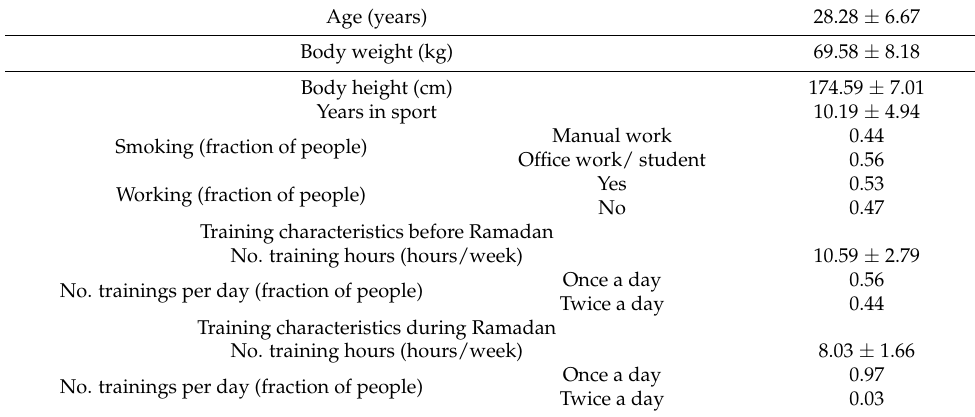
Table 1. Anthropological and training characteristics of the study participants (n = 32).